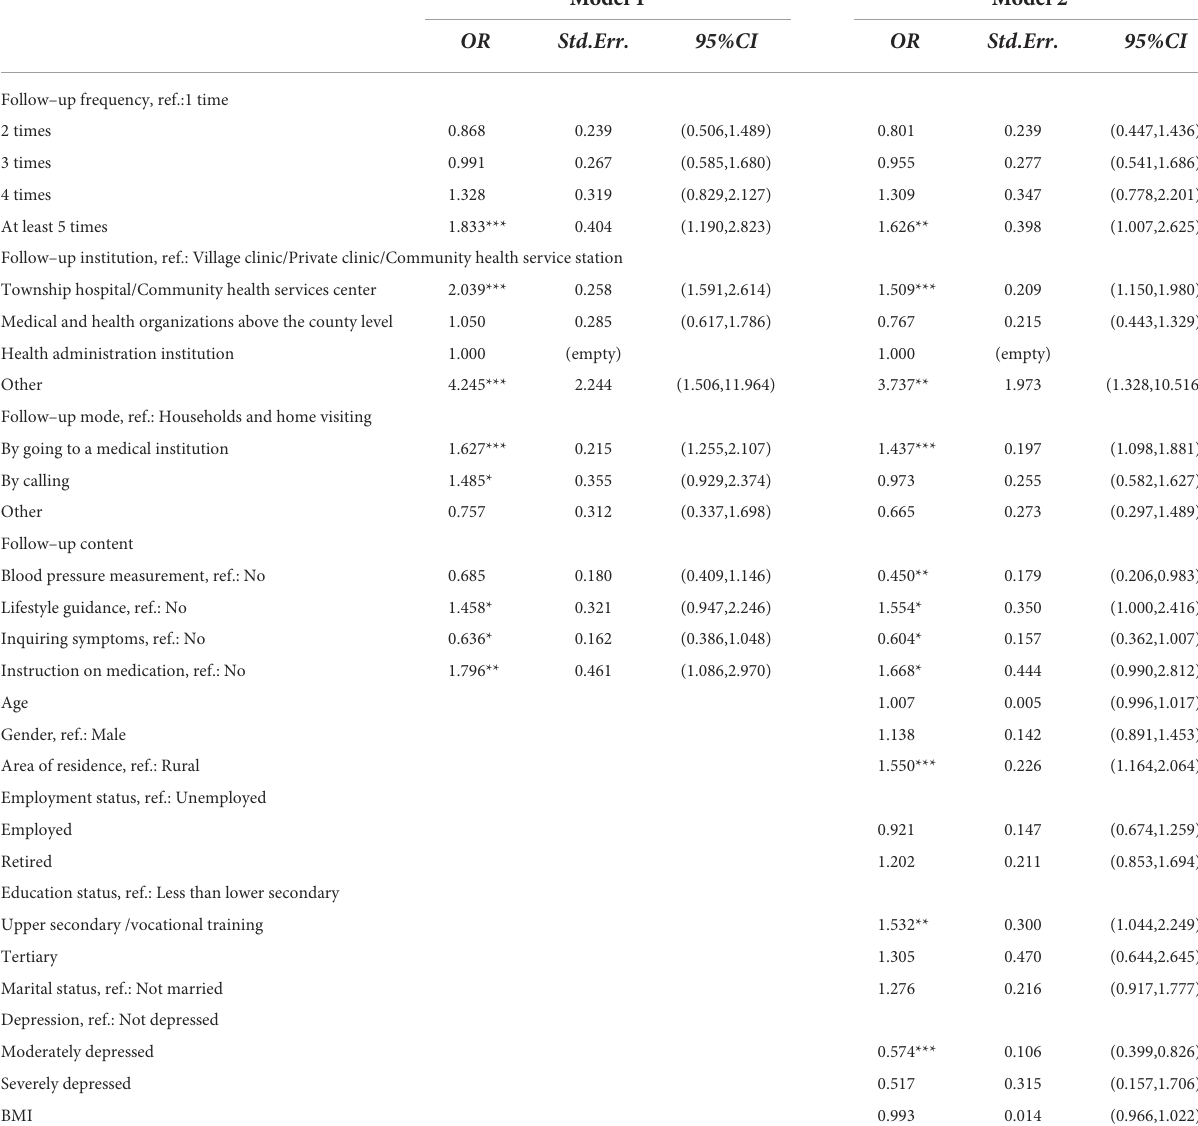
TABLE 5 Logistic regression model on control of blood pressure in hypertensives received follow–up ( n = 1679). Model 1 Model 2 OR Std.Err. 95%CI OR Std.Err.